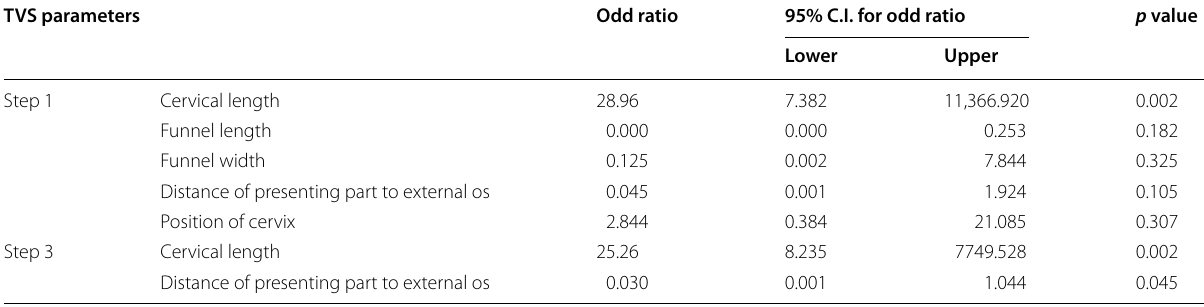
Table 5 Results of binary logistic regression for outcome of induction TVS parameters